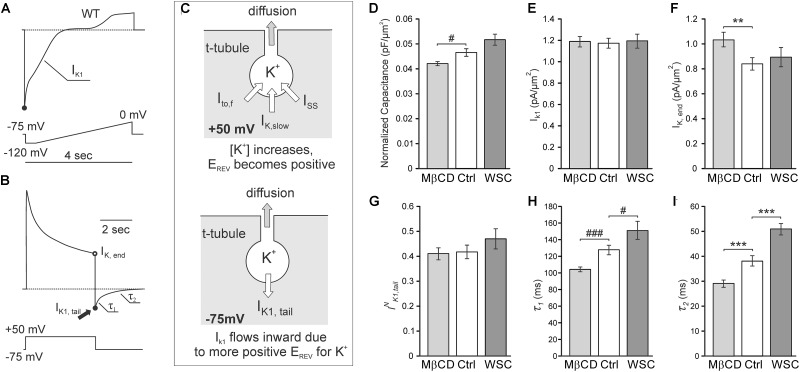
Electrophysiological properties of cholesterol depleted and supplemented cardiomyocytes. (A) Cartoon trace of IK1 current in response to a slow ramp protocol. (B) Cartoon trace of outward K+ currents in response to a 400 ms step depolarization to +50 mV and inward IK1,tail in response to a step repolarization back to –75 mV. The amplitude of IK1,tail and its kinetics (characterized by time constants τ1 and τ2) are measures of diffusional properties of TATS. (C) Cartoon diagram depicting the origin of the IK1,tail. Top: outward potassium currents cause the accumulation of potassium within the t-tubular lumen during depolarization. Bottom: upon repolarization, the accumulated potassium can either flow into the cell through IK1 channels producing the IK1,tail or diffuse out of the t-tubular lumen to the extracellular space. (D–G) Quantification of the membrane capacitance normalized to the cell cross-sectional area (D), peak IK1 current normalized to the cell cross-sectional area (E), steady-state IK,end
(F), and IK1,tail amplitude normalized to the steady-state IK,end current. n = 35 control, 40 MβCD, and 16 WSC-treated cells. (H,I) Quantification of the slow (H) and fast (I) time constants of IK1,tail decline. n = 37 control, 39 MβCD-, and 16 WSC-treated cells.